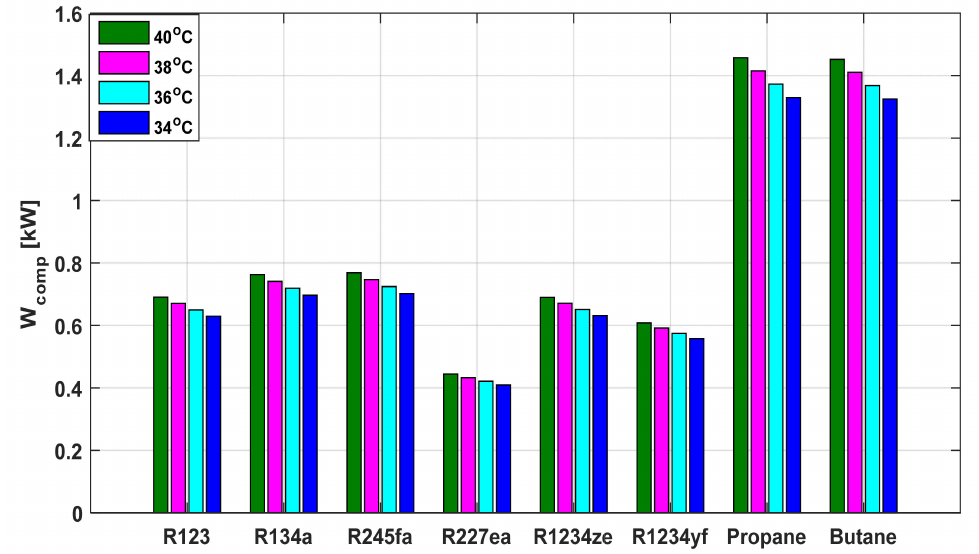
Figure 4. The required compressor work for considered working fluids at fixed condenser temperature.